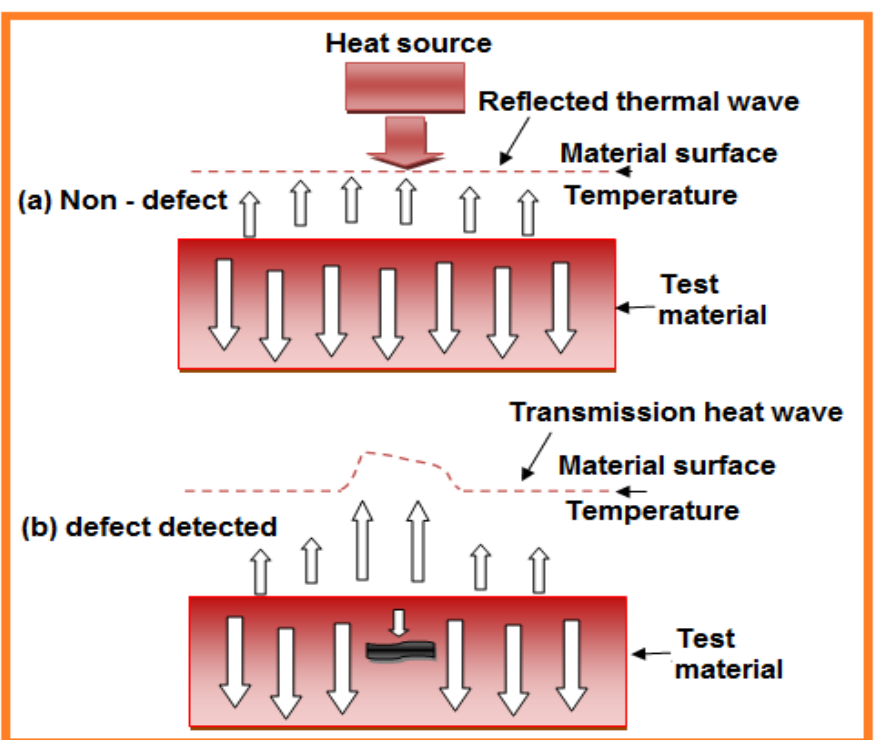
Figure 12. Schematic diagram of thermal wave imaging object detection: ( a ) non-defect; ( b ) defect detected object.